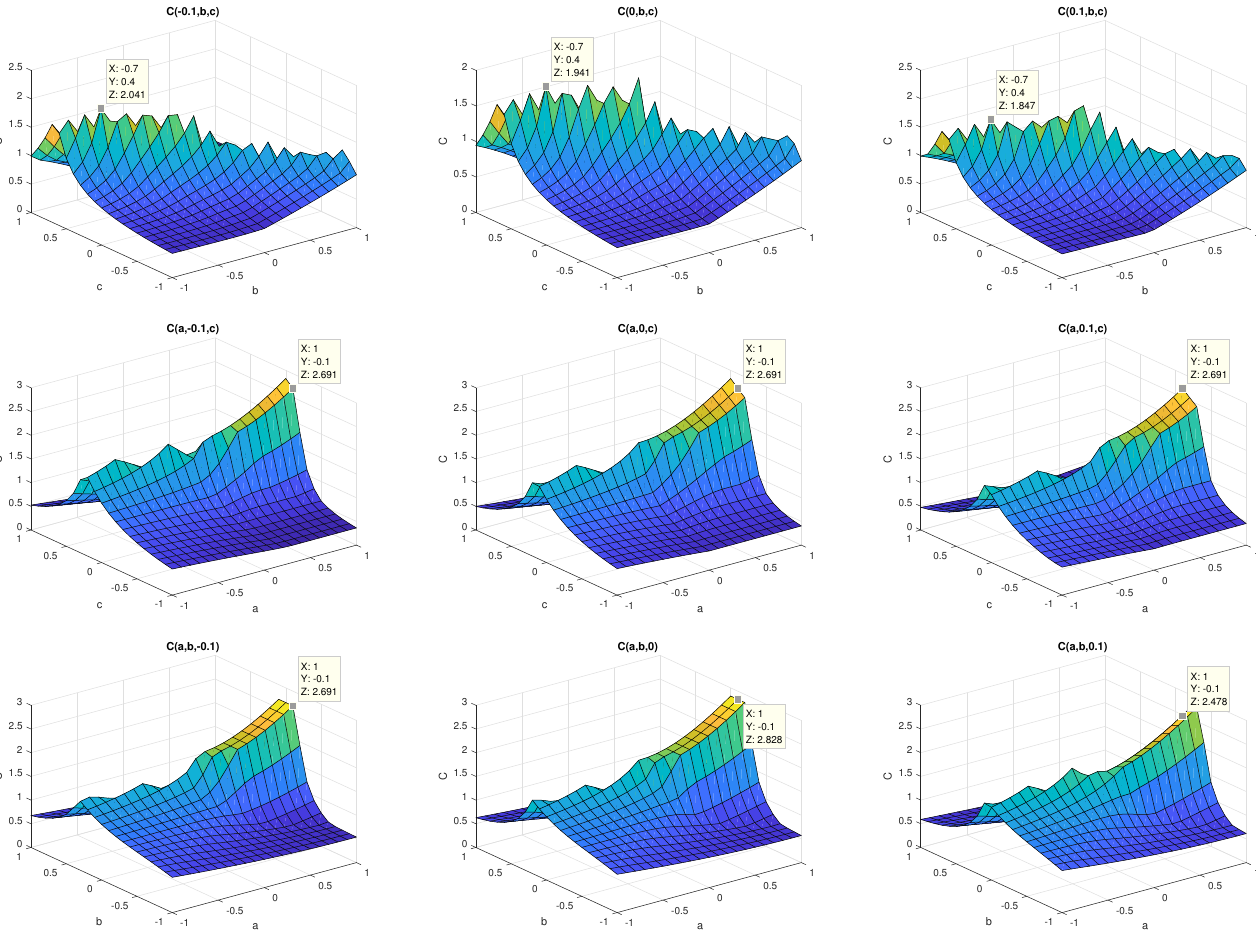
Figure 1. Influence of the coefficients u on the objective function C 4 . Three coefficients are selected: a 0 (first row), a 1 (second row), and a 2 (third